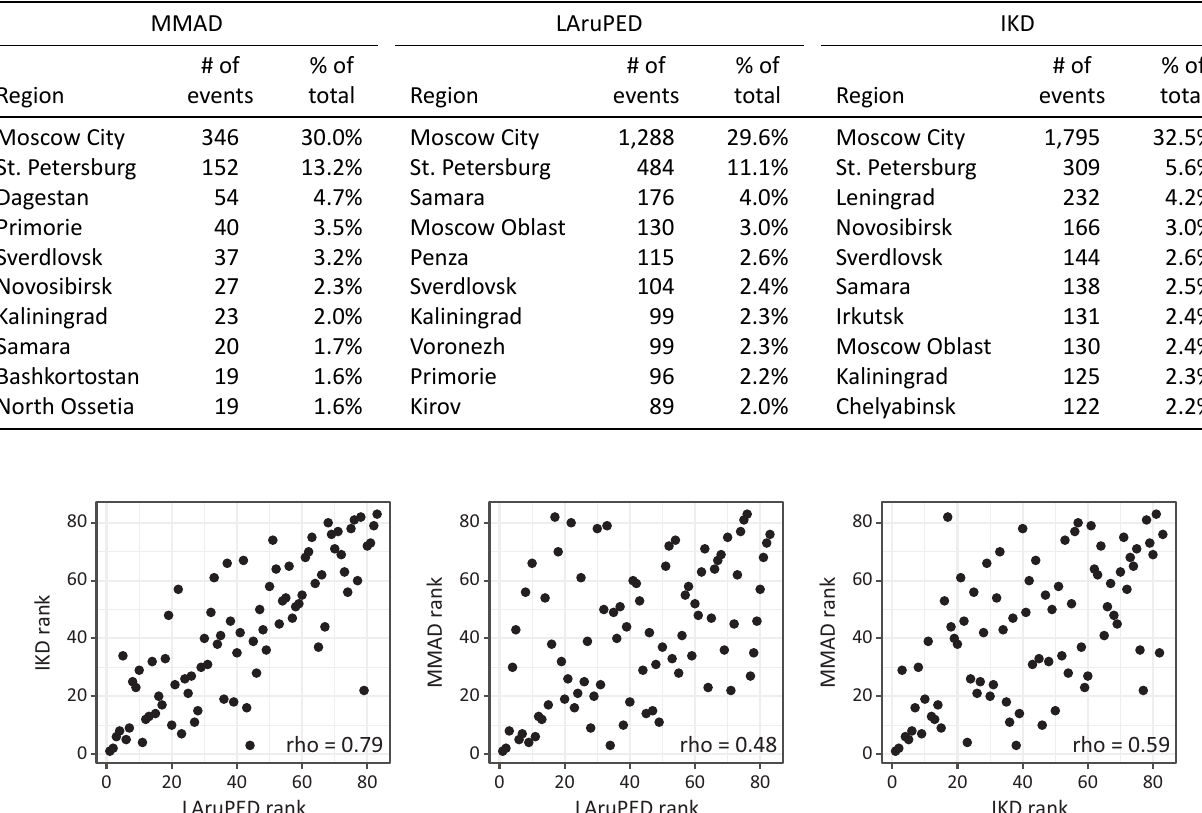
Table 2. Regions with the highest number of events per data source (March 16, 2007–March 5, 2012). MMAD LAruPED